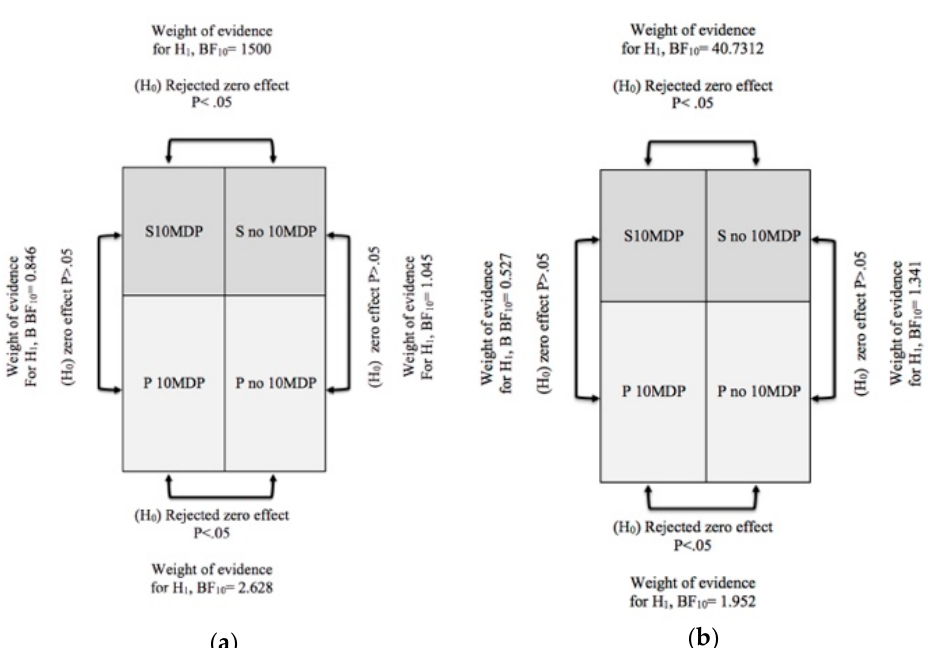
Figure 5. Summary of the results of Bayesian analysis performed for independent samples with Rouder method; BF 10 = evidence for H 0 and H 1 hypotheses. ( a ) Maximum load test (ML); ( b ) Shear bond strength test (SBS).